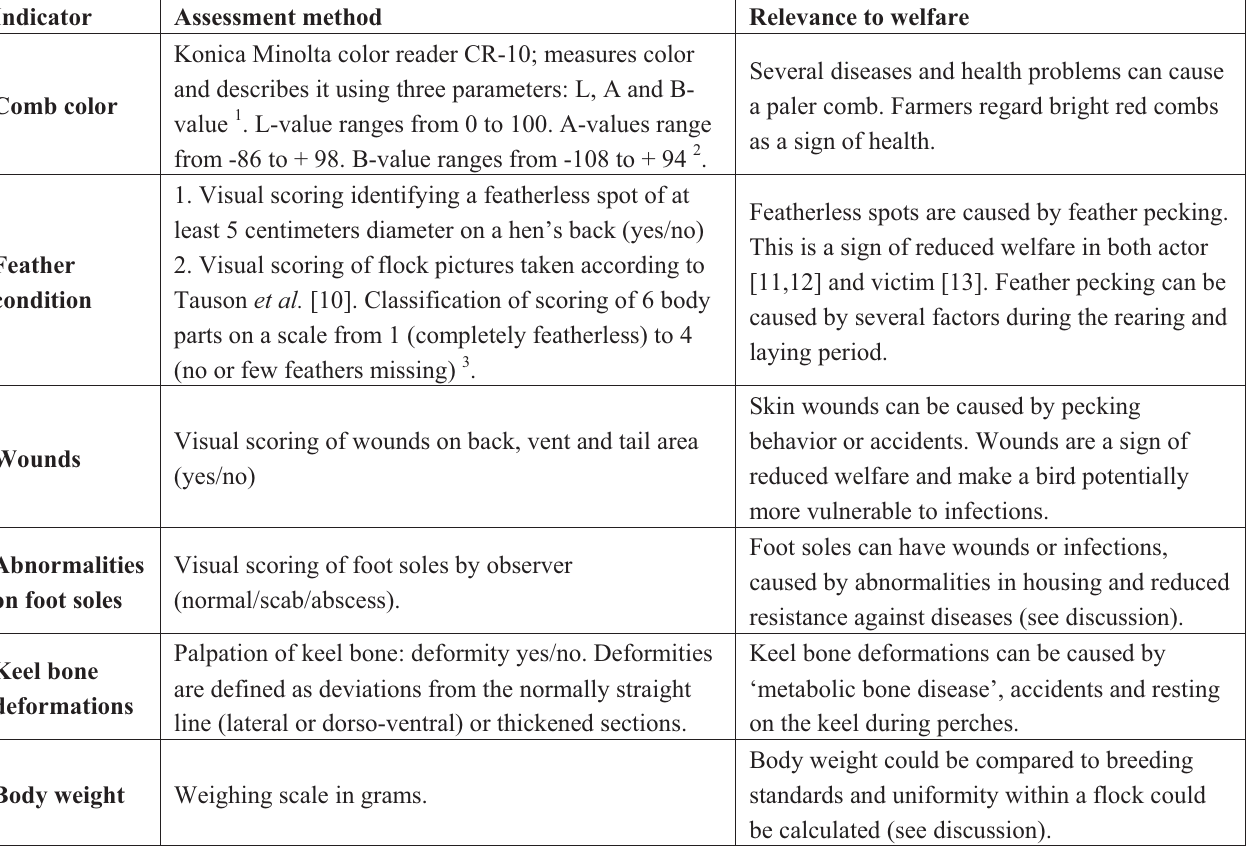
Table 1. Methods used for body condition